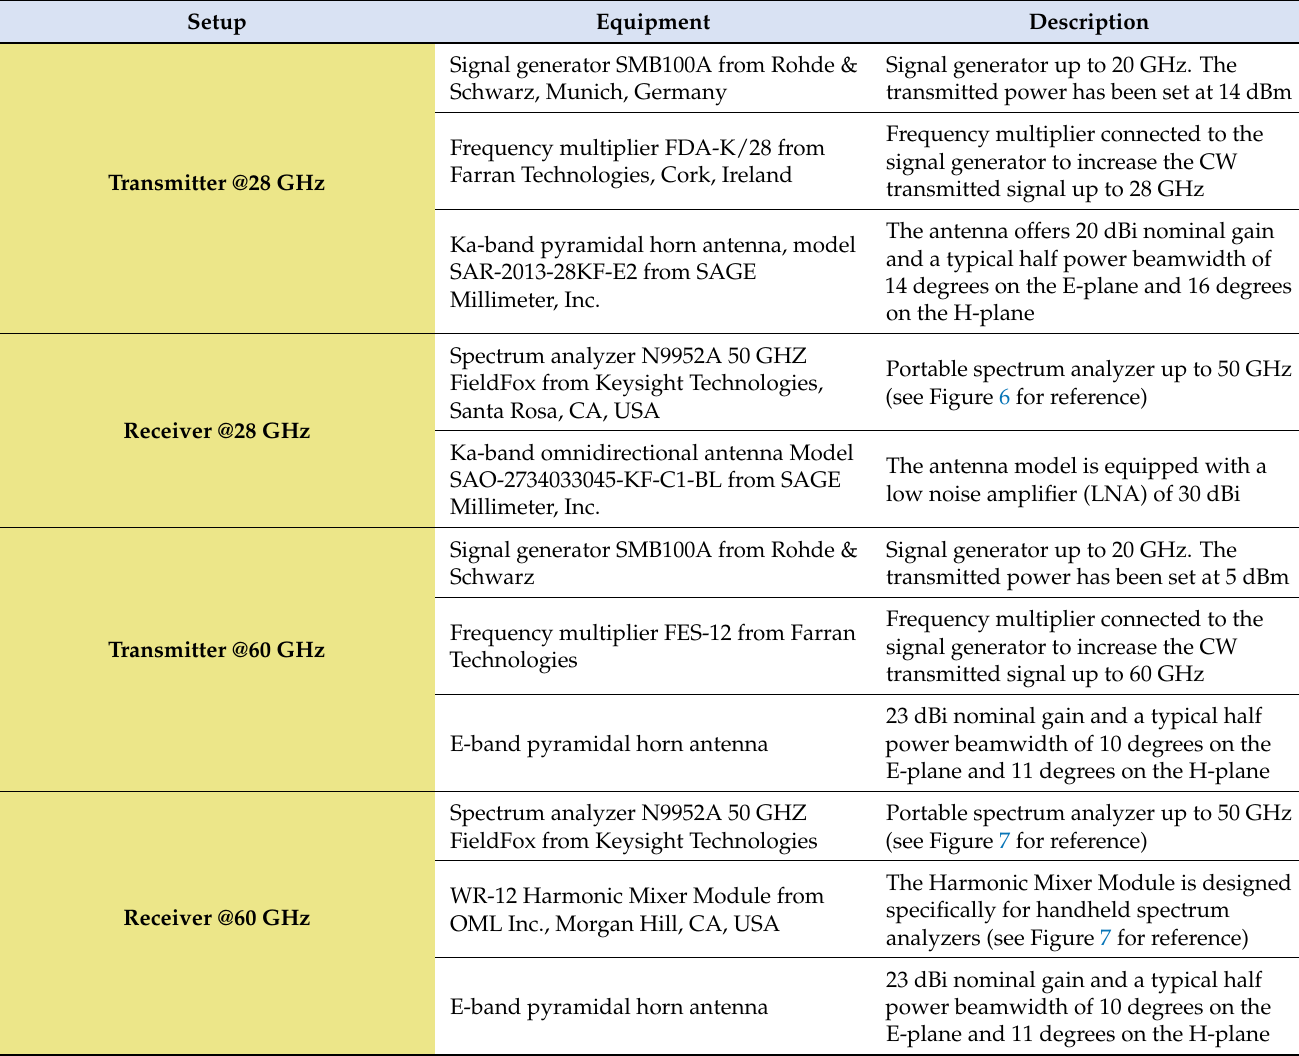
Table 5. Measurement transmitter/receiver setup summaries for both frequencies under